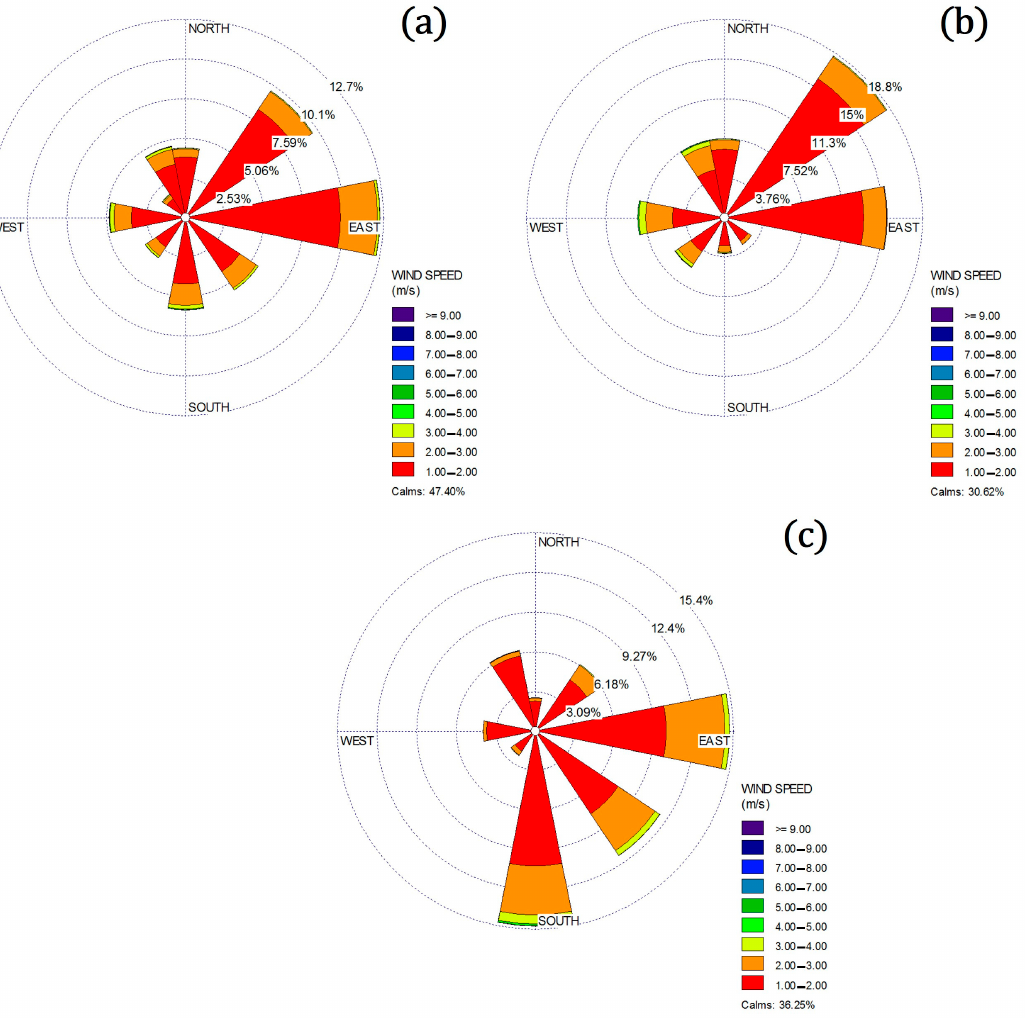
Figure 2. Annual wind roses with wind speed (m/s) and direction for Castro ( a ), Curitiba ( b ), and Paranaguá ( c ).